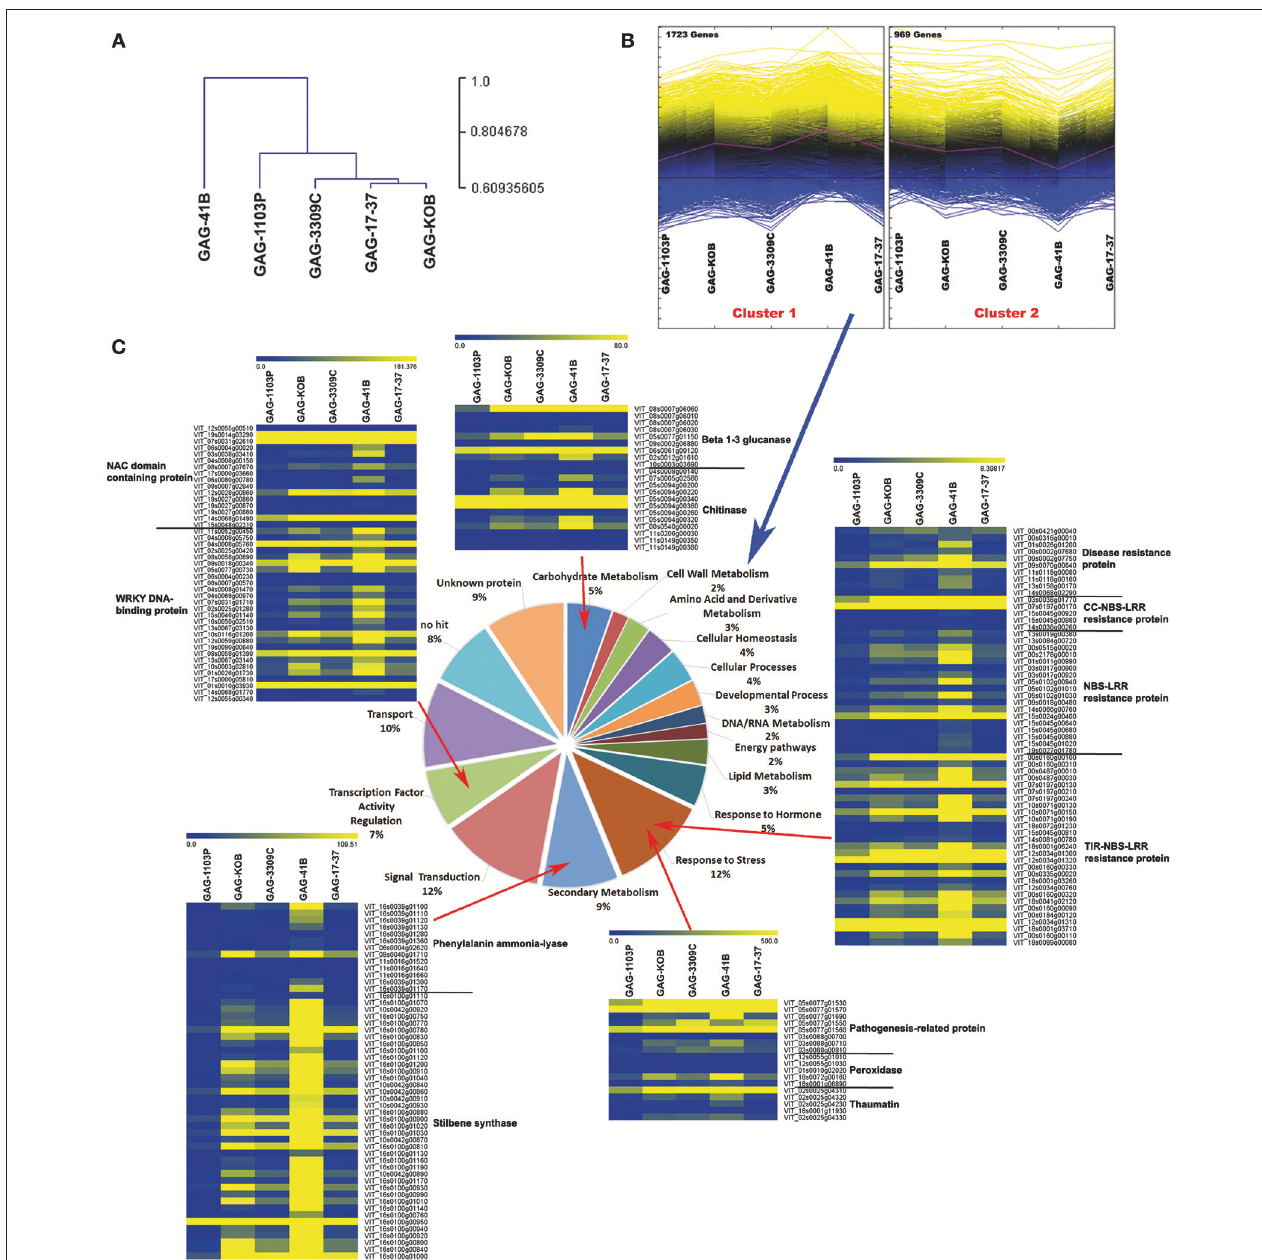
FIGURE 3 | Transcriptomic reprogramming induced in the scion “Gaglioppo” by different rootstocks. Cluster dendrogram of GAG-41B, GAG-1103P, GAG-3309C, GAG-17-37, and GAG-KOB obtained using the average expression value of the three biological replicates (A) . Hierarchical clustering analysis of transcripts that were differentially modulated among the five different graft combinations ( P < 0.05; |log2FC| ≥ 2) (B) . Functional category distribution of the transcripts belonging to Cluster 1, grouped into the most represented functional categories, based on the GO classification of biological processes (C) . The heat maps of transcriptional profiles associated with the categories “Carbohydrate metabolism,” “Response to stress,” “Secondary metabolism,” and “Transcription factor activity regulation” were generated with TMeV 4.9 using the average expression value of the three biological replicates.